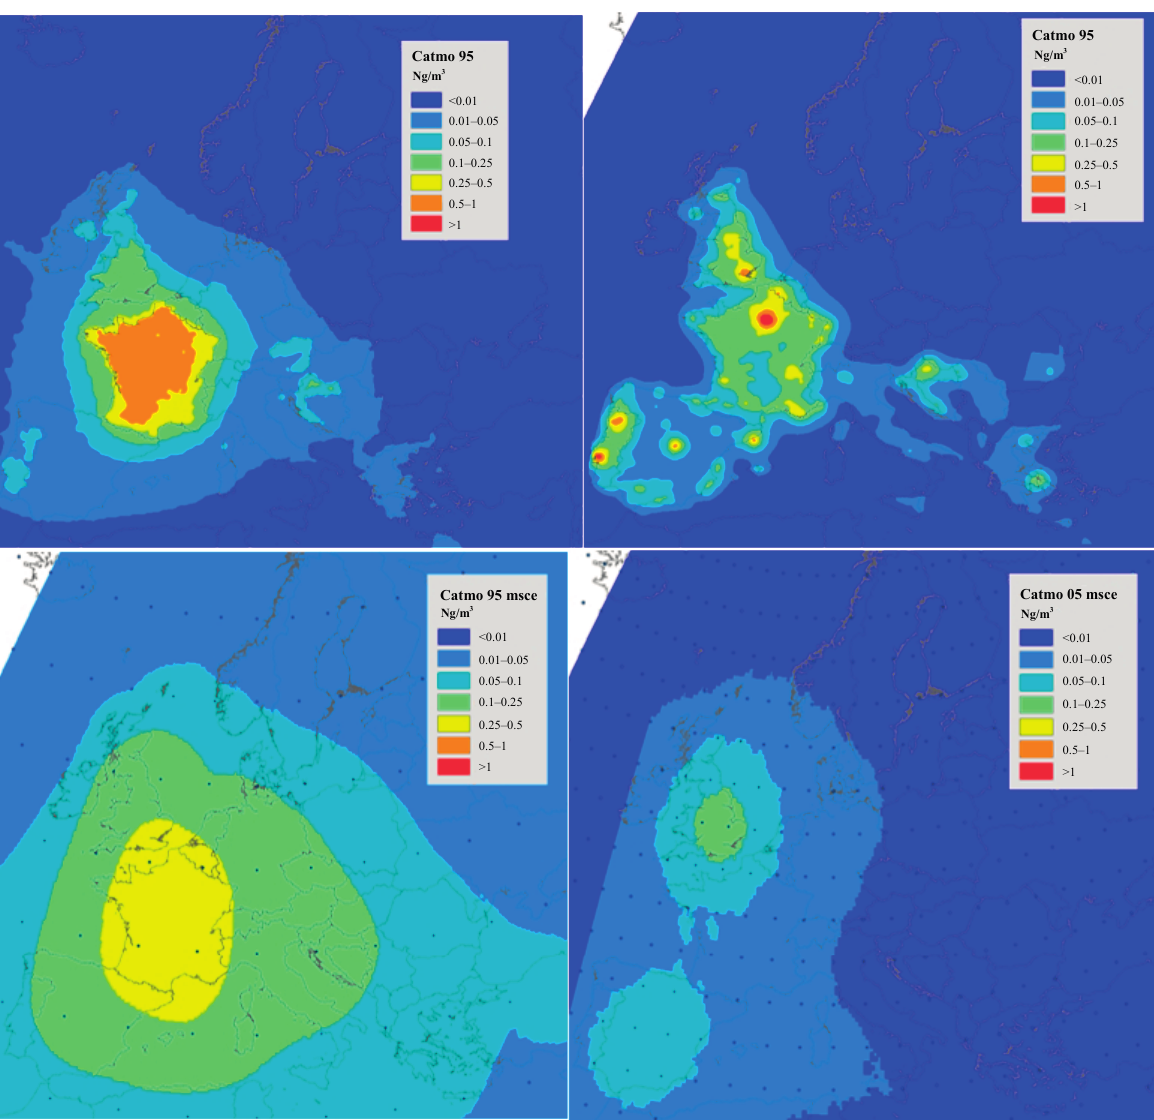
Figure 1. Modeled values of concentrations of γ -HCH expressed as concentrations (ng/m 3 ) in atmosphere in 1995 (left ) and 2005 ( right ) using Equation (5) ( top ) and the EMEP MSCE-persistent organic pollutant (POP) model ( bottom ). Concentrations from the MSCE-POP model were provided by A. Gusev, [44] and reflect model setups and assumptions also described in